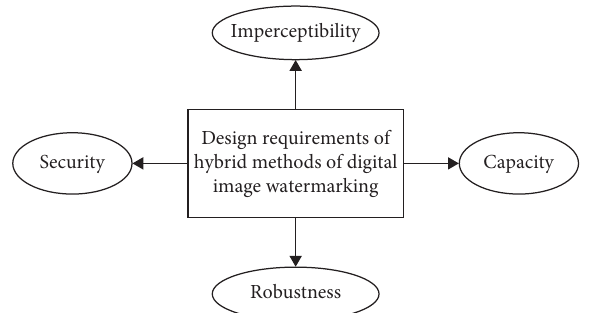
Figure 3: Basic requirements of hybrid digital image